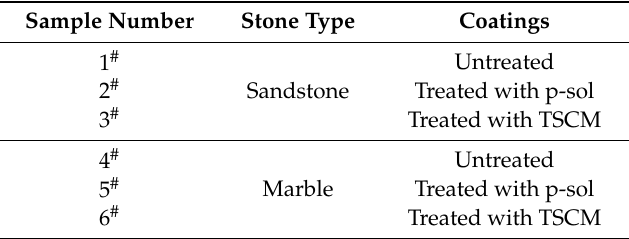
Table 1. Numbers of stone samples. TSCM, TiO 2 -modified sol coating material. Sample